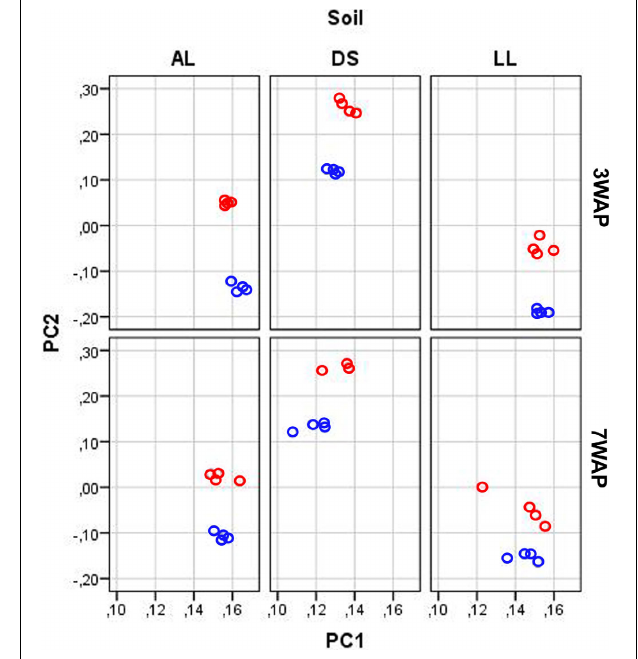
FIGURE 2 | Principal component analysis of the bacterial community composition according to pyrosequencing data. The relative abundance of OTUs (log transformed) in samples from rhizosphere (red circles) and bulk soil (blue circles) taken 3 and 7 weeks after planting (3WAP, 7WAP) of lettuce in soils DS, AL, and LL were compared. The first and second principal components are shown which explained 47 and 9% of the total variance, respectively. The data were analyzed together, but for clarity separated plots for each soil type and sampling are